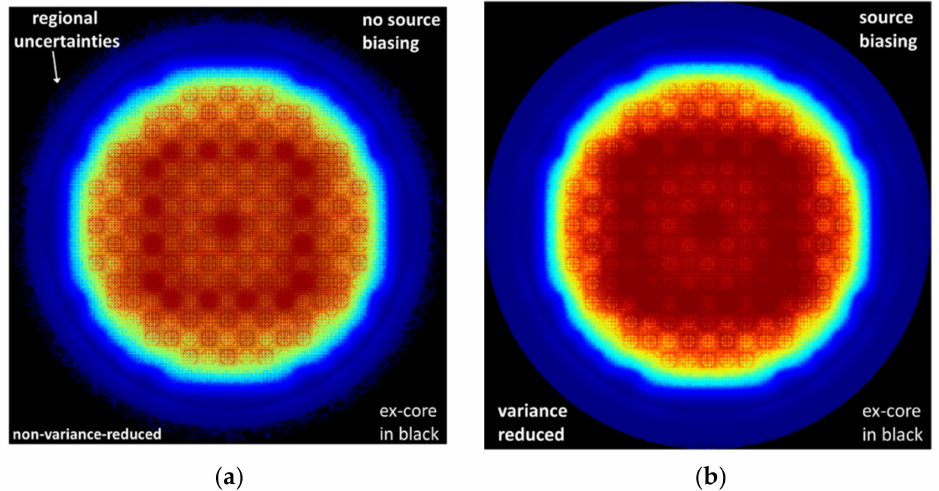
Figure 10. Serpent mesh plots (radial view) of the EPR full-core relative collision density: ( a ) no source biasing; ( b ) with source